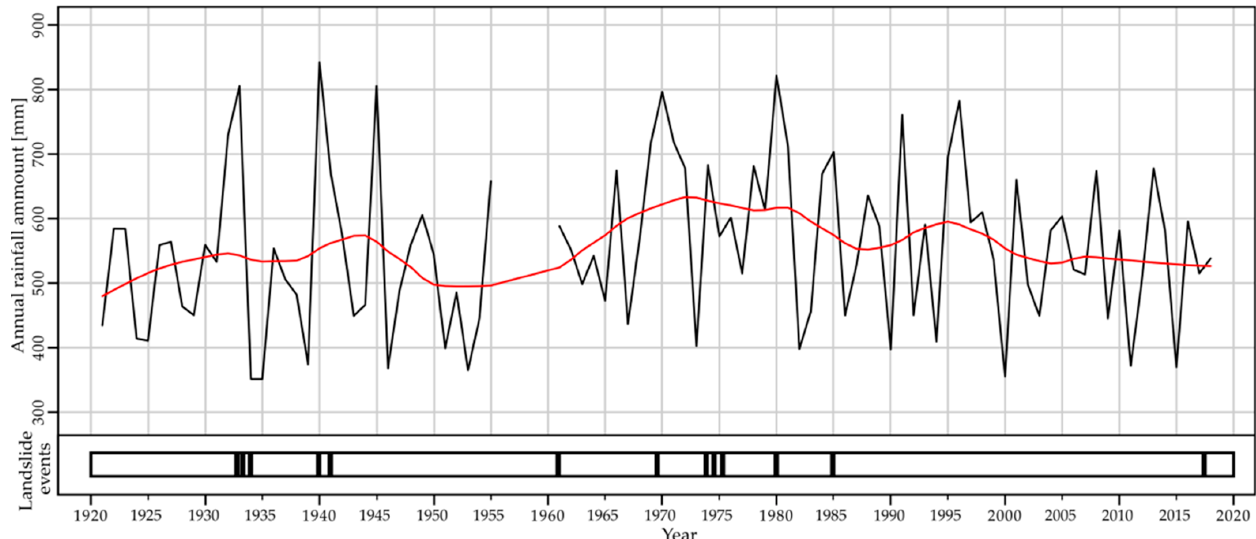
Figure 2. Mean annual rainfall measured at the Ia¸si meteorological station (1921-1955 data from [85], and 1961–2018 data from ECA&D [86,87]). The red line indicates the polynomial loess smooth trend with a 0.5 span. At the bottom are represented the landslide events in the Municipality of Ia¸si as reported by [77,79]. (high-resolution image available at https://doi.org/10.6084/m9.figshare.14915148.v1).